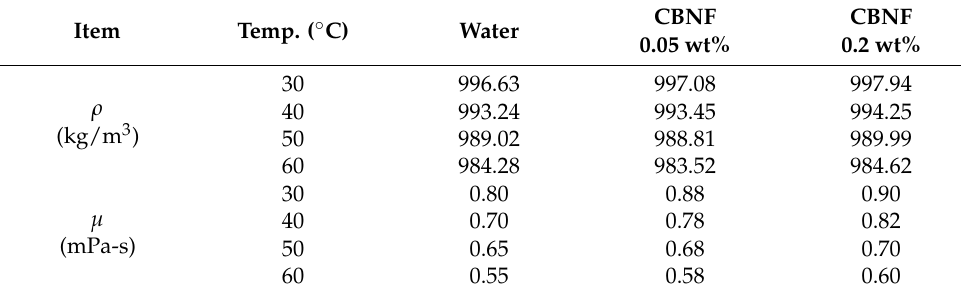
Table 2. List of µ and ρ for working fluids. Table 2. List of μ and ρ for working fluids.